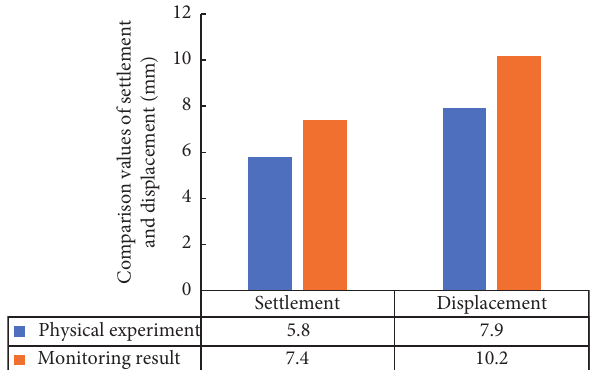
Figure 13: Comparison between the results of settlement and displacement.